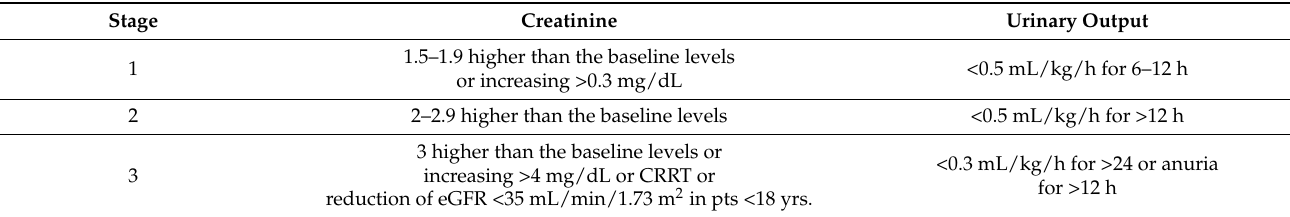
Table A1. As far as staging is concerned, KDIGO identifies three levels.